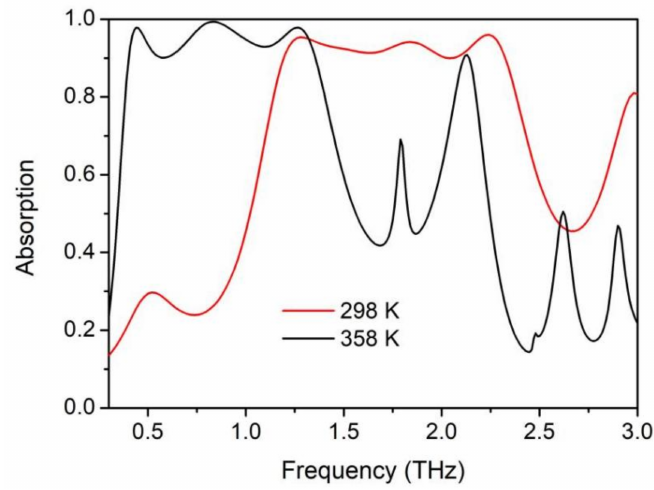
Figure 7. Absorption spectra at 298 K (conductivity of VO 2 is about 200 S/m) and 358 K (conductivity of VO 2 is about 200,000